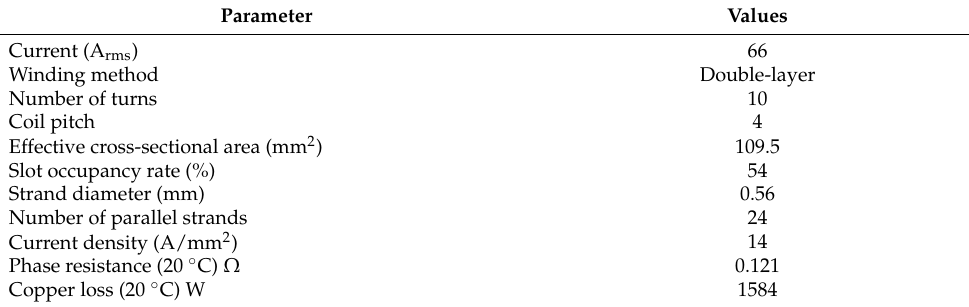
Table 3. Electric parameters of